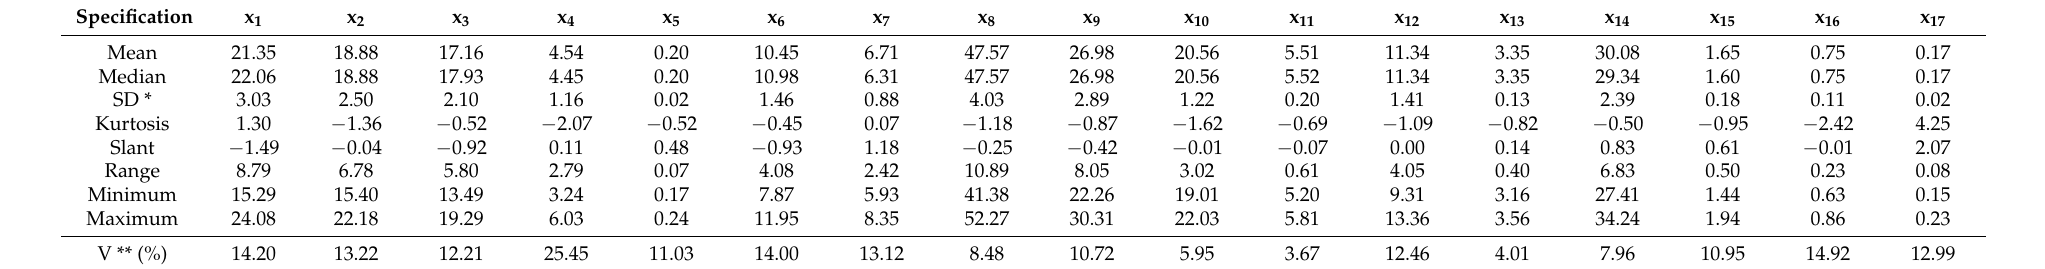
Table 6. Descriptive statistics of chemical components of tubers.